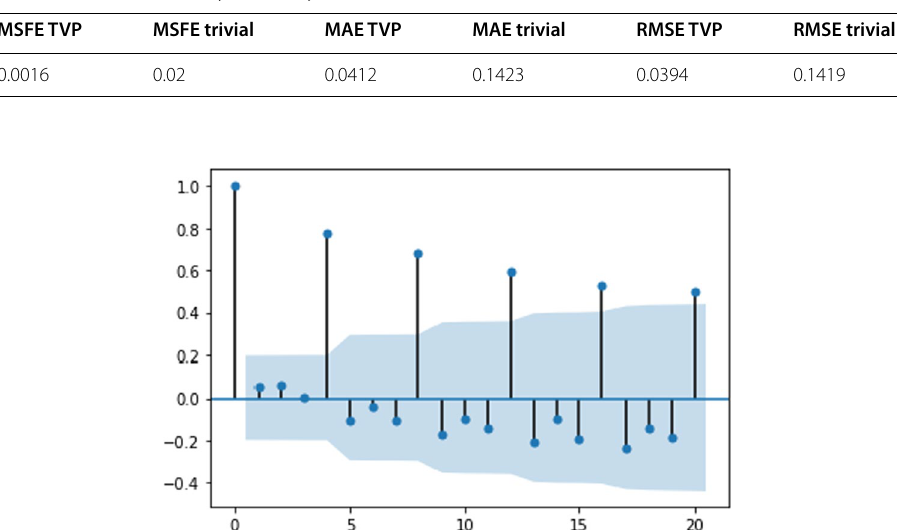
Table 2 Model efficiency summary for US e-trade volume